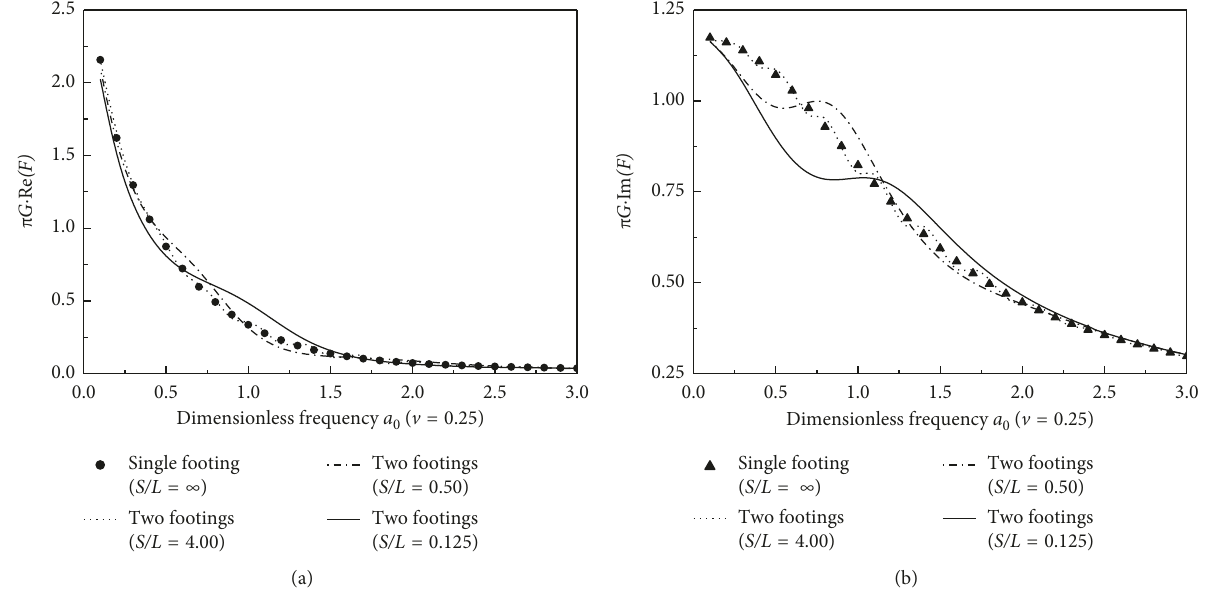
Figure 11: Vertical flexibility F ( a